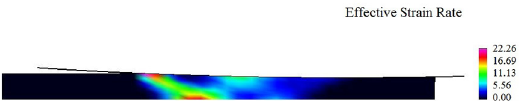
Figure 6. Effective strain rate - thickness of 3.0 mm, velocity of 104.72 mm/s and reduction of 16.67% (simulation 5). In relation to the effective strain, results in Figures 7 and 8 show an increasing strain value from the beginning of the reduction to the exit of the sheet. The higher values of effective strain after the sheet leaves the roll appear on the sheet surface and in its central region. This behavior is a consequence of the effective strain rate results: the higher values of this variable also appear on the sheet surface and in its central region. The results shown in Figures 7 and 8 are similar to those from RICHELSEN 29 . Table 4. Force versus friction - simulation 5: coefficient of friction of 0.1; simulation 6: coefficient of friction of 0.3. Simulation